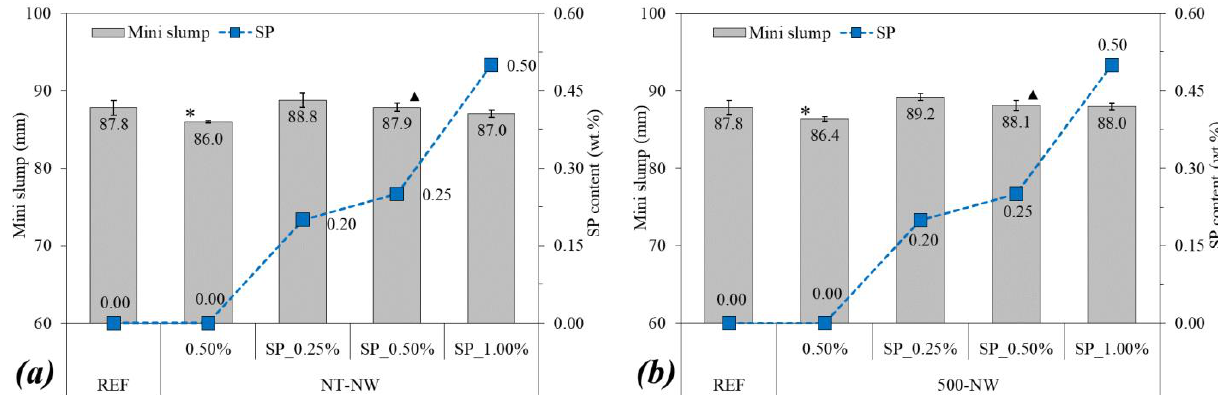
Figure 3. Mini slump and superplasticizer (SP) content of ( a ) NT-NW and ( b ) 500-NW-based systems. Stars indicate significant differences in comparison with REF and triangles indicate significant differences between the samples with and without SP.